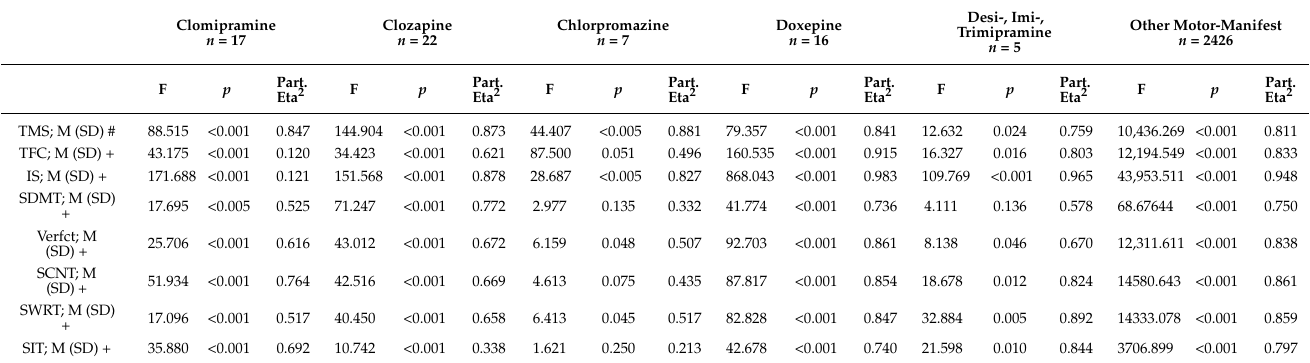
Table 4. Comparison of baseline analysis and follow-up after two years.